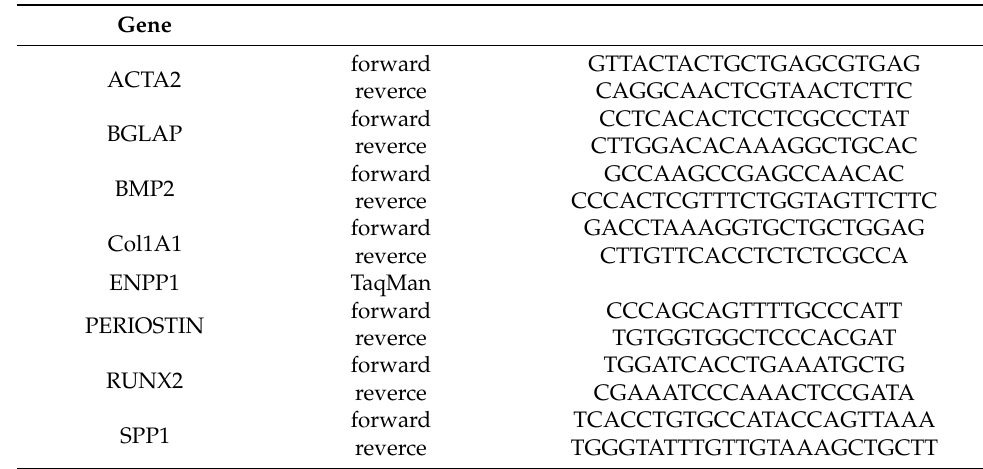
Table A2. Sequence of the primers used for the